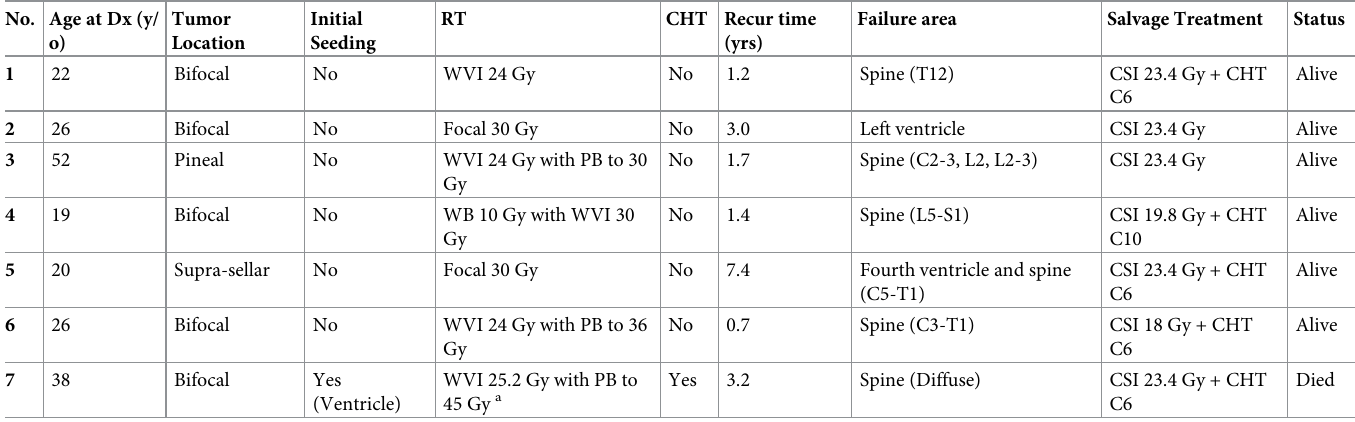
Table 2. The detailed information and failure pattern of 7 recurrent